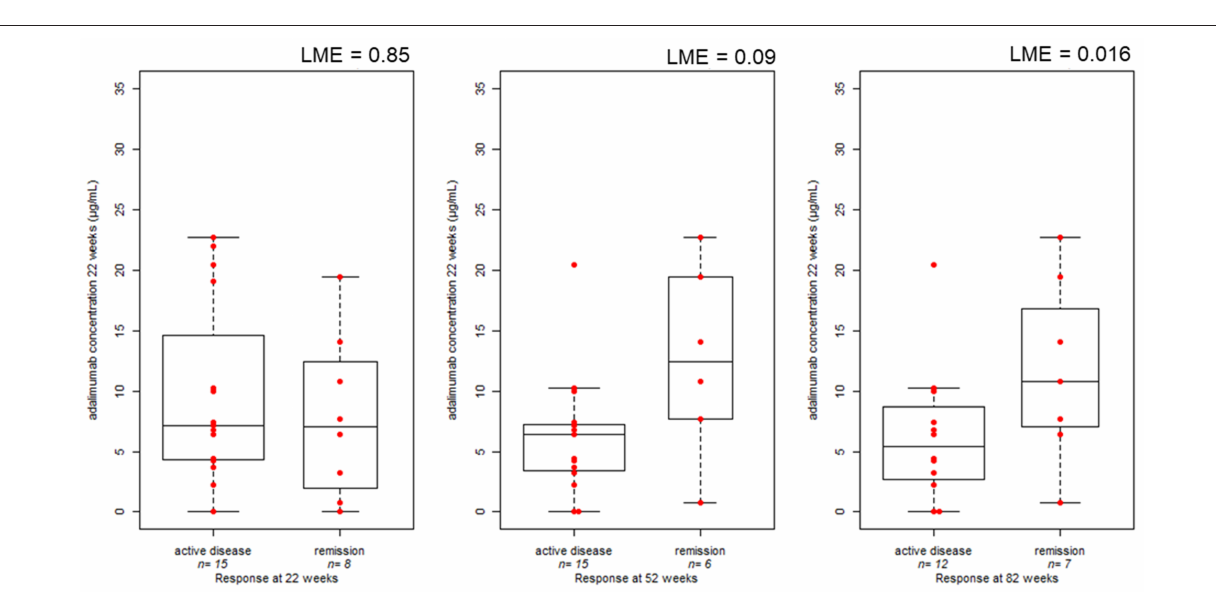
with fecal calprotectin measured during the induction: patients not achieving the cutoff for adalimumab concentrations had significantly higher fecal calprotectin compared with others, and marginally significant results were observed for CRP ( Supplementary Figure 7